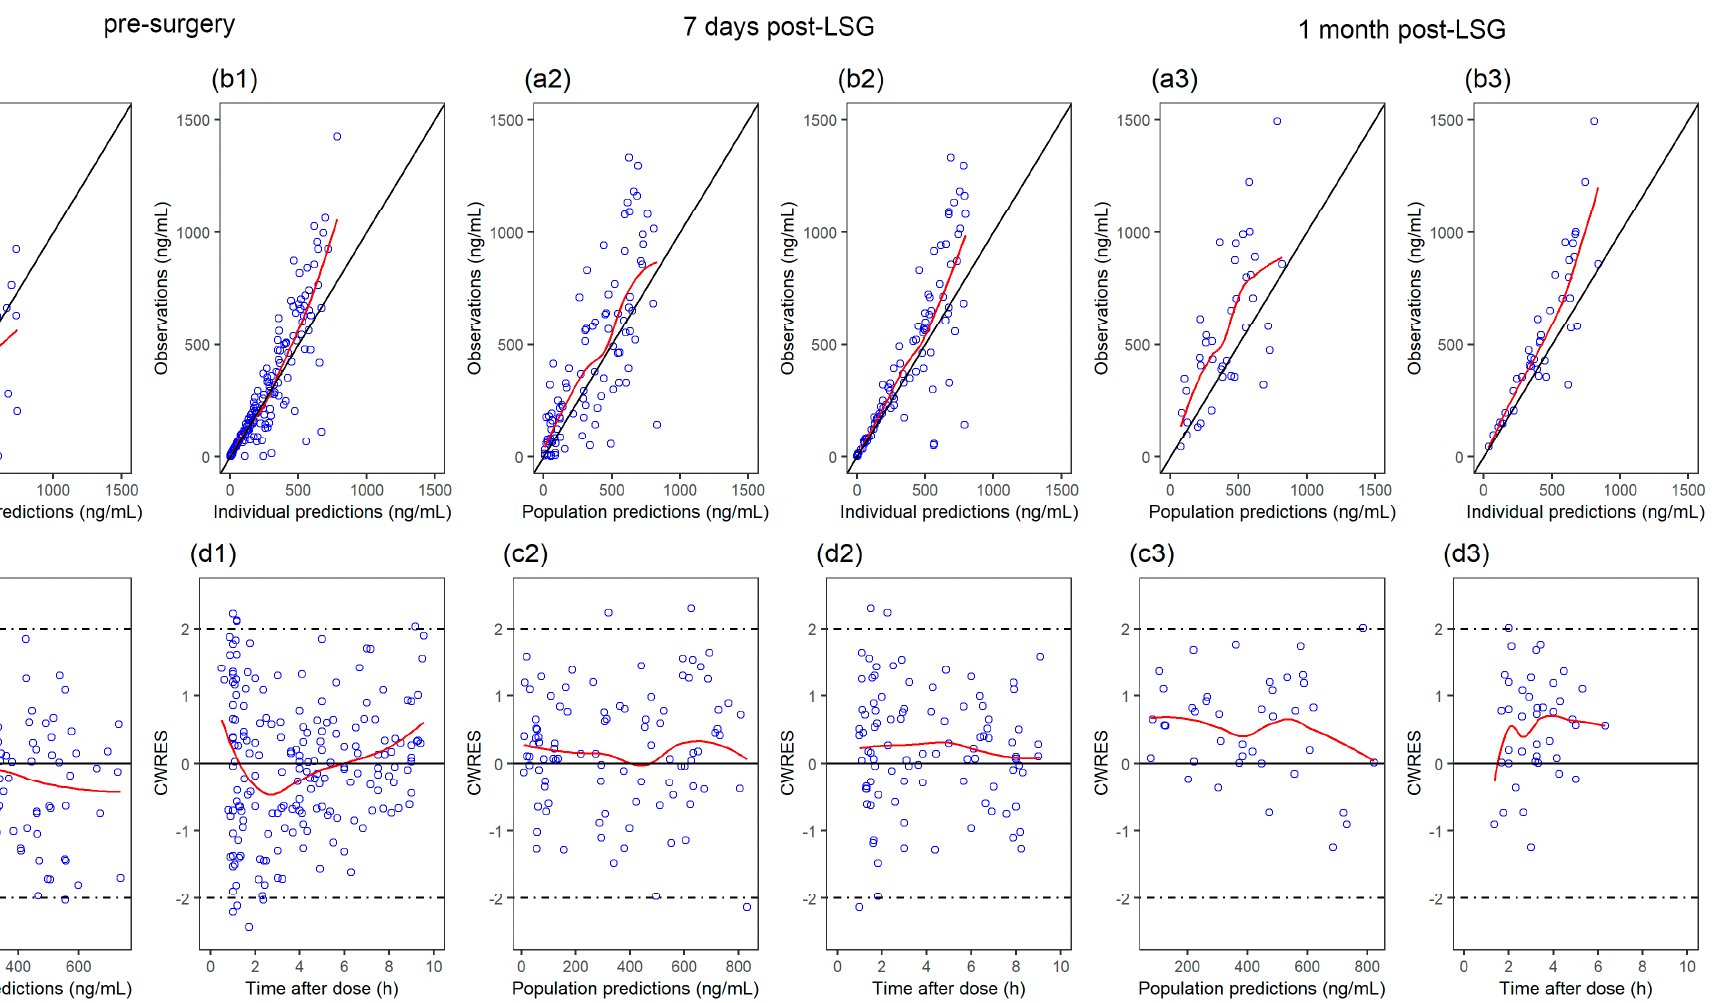
Figure 1. Goodness-of-fit plots for the final model at each visit: ( a1 , a2 , a3 ) observations versus population predictions (PRED); ( b1 , b2 , b3 ) observations versus individual predictions (IPRED); ( c1 , c2 , c3 ) conditional weighted residuals (CWRES) versus PRED; ( d1 , d2 , d3 ) CWRES versus time after dose.